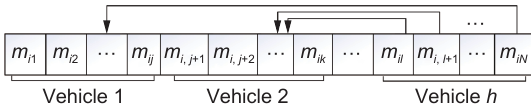
Fig. 6 2-opt for M . Fig. 7 Single node insertion for M i